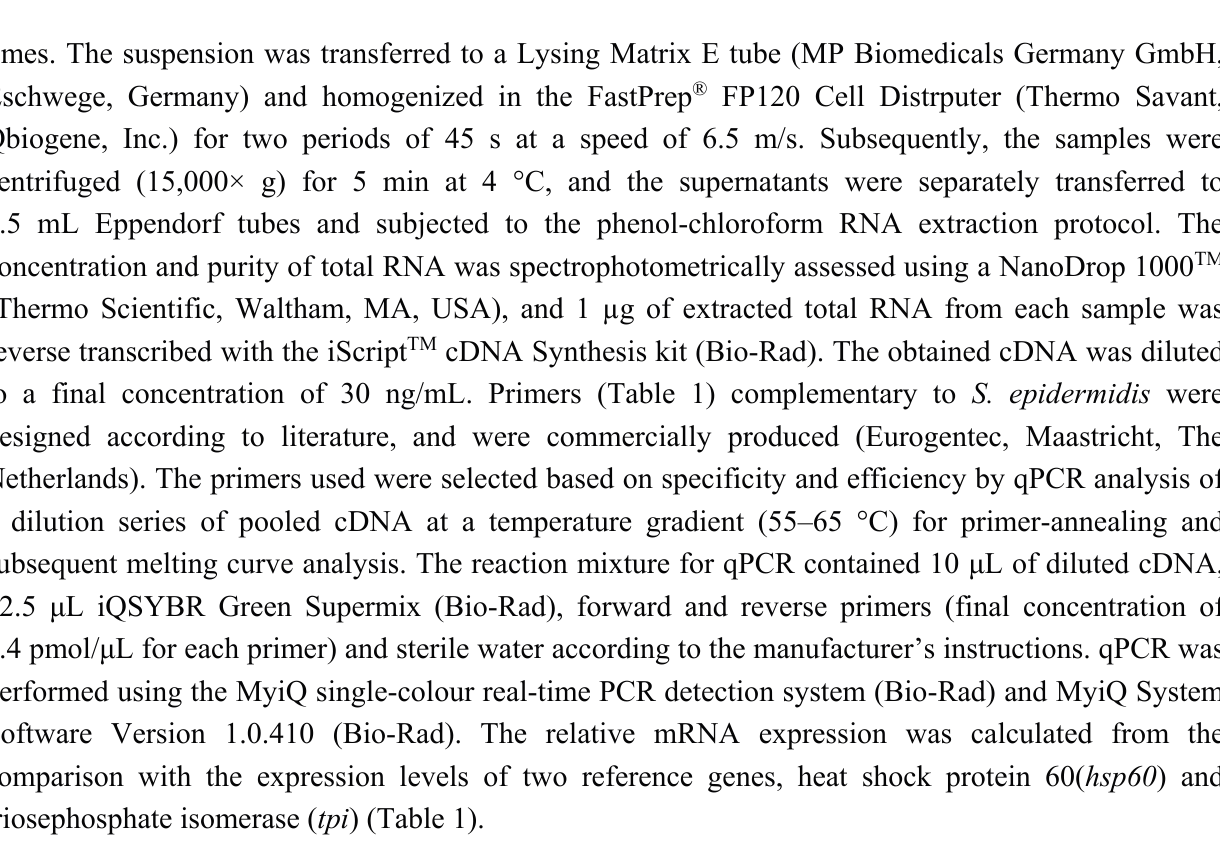
Table 1. Primer sequences used in this